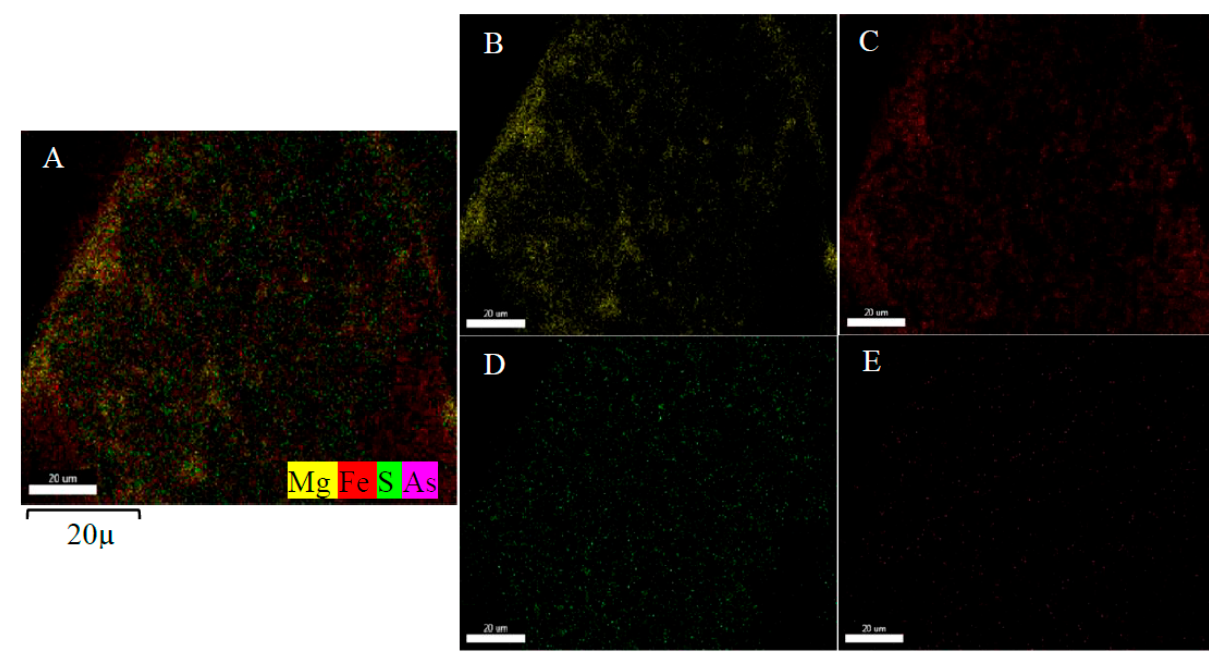
Figure 3. Iowaite-NaAsO 2 EDS images of each element channel (( A ) covers channels of Mg, Fe, S and As, ( B ) is the channel of Mg, ( C ) is the channel of Fe, ( D ) is the channel of S, ( E ) is the channel of As).